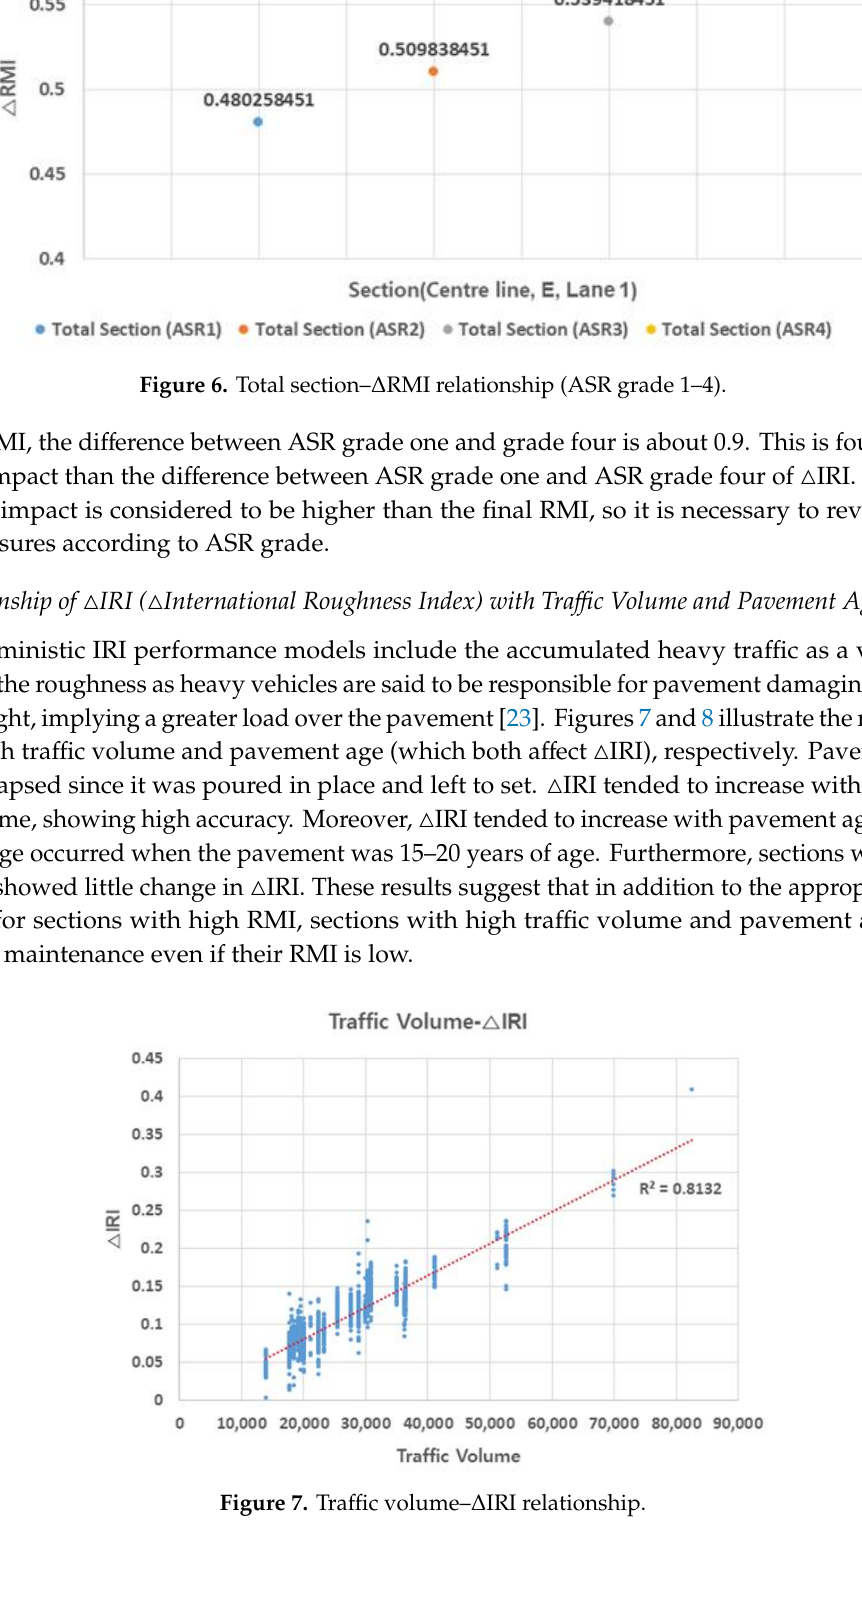
Figure 8. Pavement age–ΔIRI relationship. 3.5. Effect of Pavement Age on △ SD ( △ Surface Distress) Figure 9 shows the effect of pavement age on △ SD. As pavement age increases, △ SD tended to increase, but this trend was concentrated within 15–20 years of age, and △ SD changed little in sections with healthy pavement. Thus, concrete pavements undergo intensive damage after 15 years